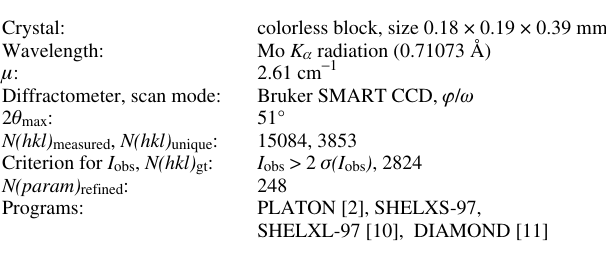
Table 1. Data collection and